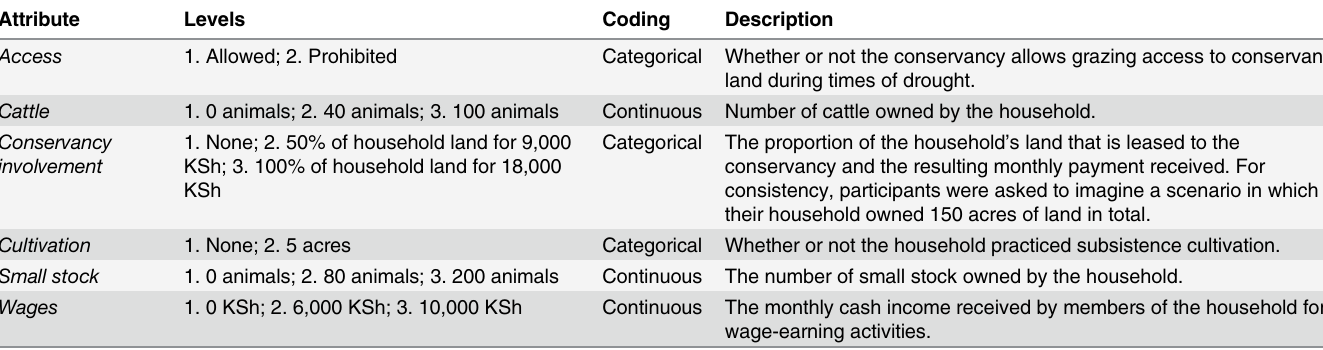
Table 2. Attributes used in the choice experiment